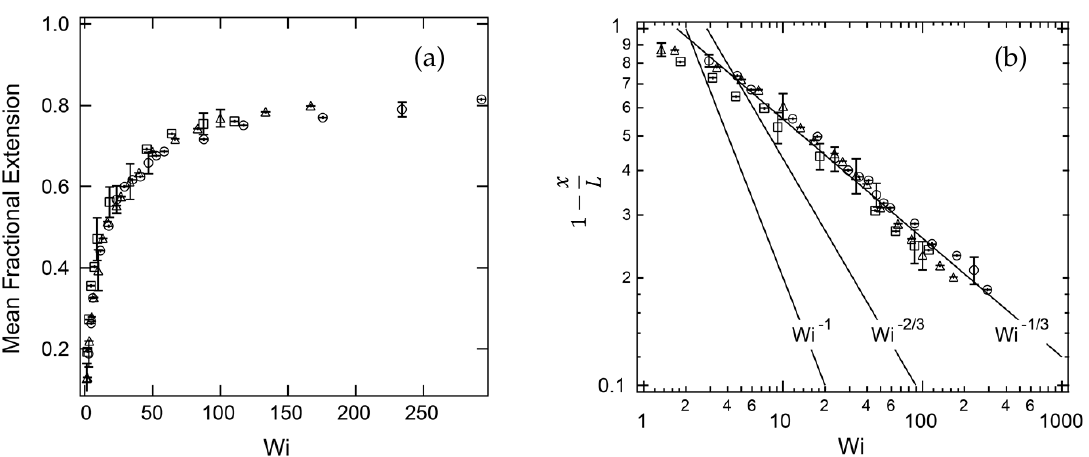
Figure 6. Experimental results obtained by Ladoux and Doyle [25]. ( a ) Mean fractional chain extension vs. Weissenberg number (Wi): L = 18.9 µ m (squares), L = 37.8 µ m (triangles), and L = 56.7 µ m (circles). ( b ) Comparison of the experimental data to scaling laws resulting from the worm-like chain, freely-jointed chain and stem and flower model. The symbols are the same as in (a).